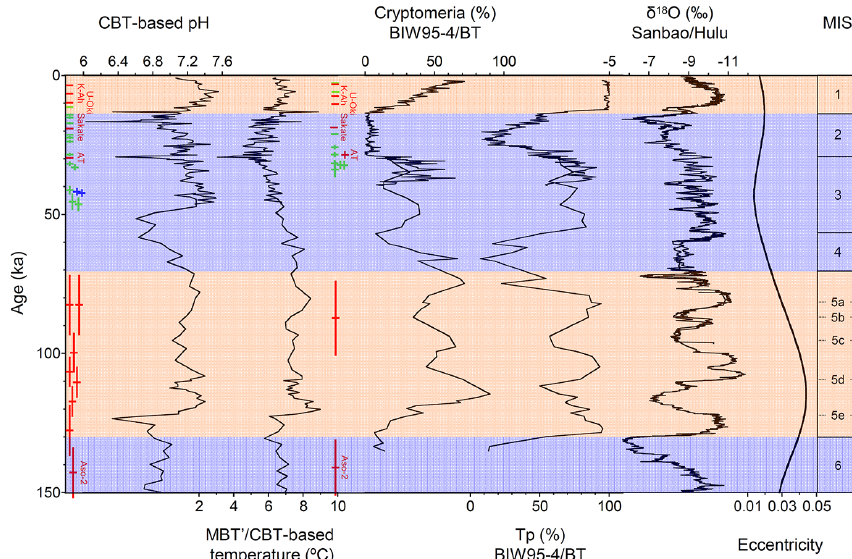
Figure 7. Variations in CBT-based pH and MBT 0 /CBT-based temperature from cores BIW07-6 and BIW08-B (this study); Tp and Cryp- tomeria (%) from cores BIW95-4 and BT in Lake Biwa (Hayashi et al., 2010a, b); the δ 18 O of stalagmites in Sanbao and Hulu caves in China (Wang et al., 2001, 2008); and eccentricity during the last 150,000 years. Red, blue, and green bars indicate age controls with 95% confidence intervals of volcanic ashes, the 14 C of plant debris and total organic carbon, and ARM events, respectively. The names of tephras that appeared commonly in BIW07-6/BIW08-B and BIW95-4/BT are shown in the